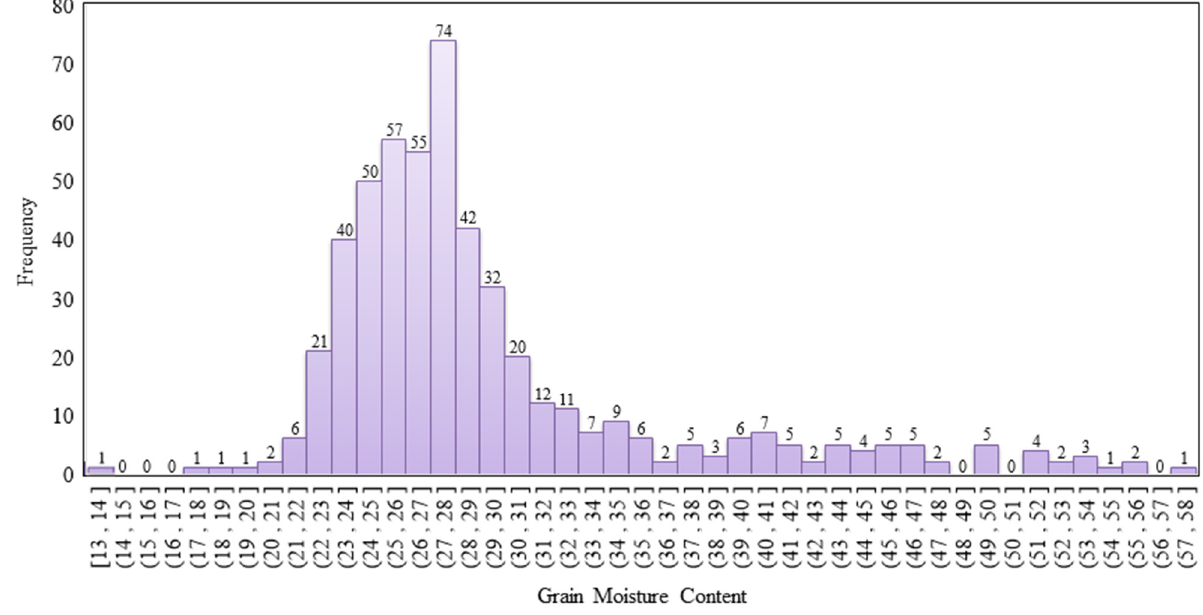
Figure 11. The distribution of the GMC among single panicle samples (N = 517, [ ]: closed interval, and ( ): open interval).